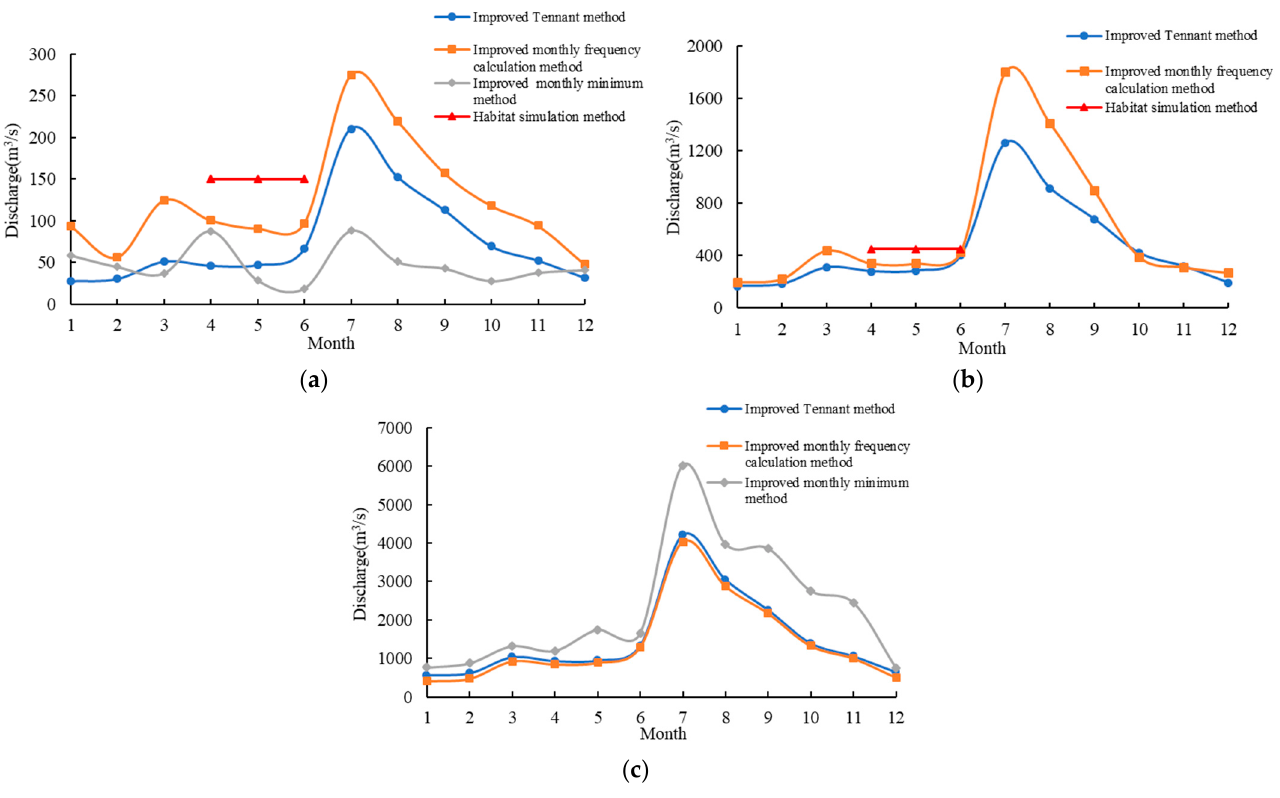
Figure 6. Results of multiple methods for computing ecological flows: ( a ) minimum ecological flow; ( b ) suitable ecological flow; ( c ) maximum ecological flow.